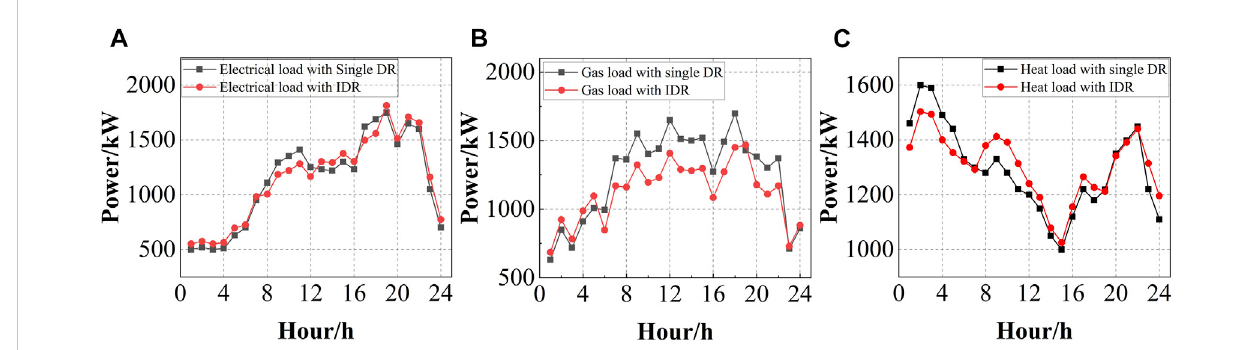
FIGURE 5 The comparison of electricity, gas and heat load participation IDR and single DR: (A) Comparison of IDR and single DR for electrical load; (B) Comparison of IDR and single DR for heat load; (C) Comparison of IDR and single DR for gas